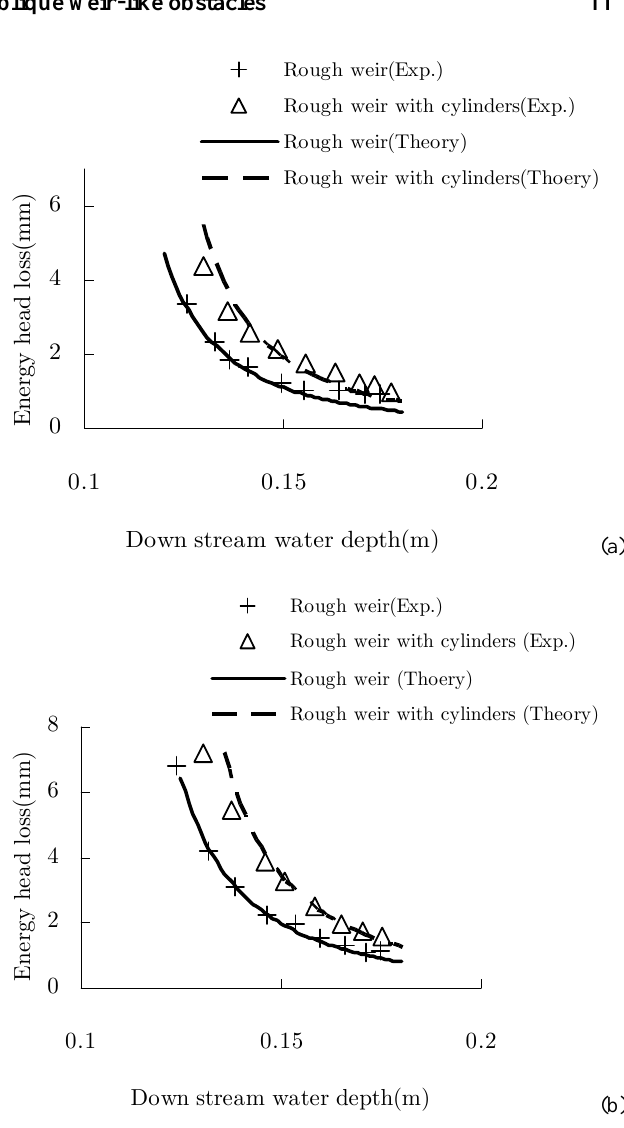
Fig. 16. Comparison of energy head loss for vegetated (submerged vegetation) and non-vegetated oblique weir (Oblique angle, 45 ◦ ), Q =40Ls − 1 (a) , Q =30Ls − 1 (b)